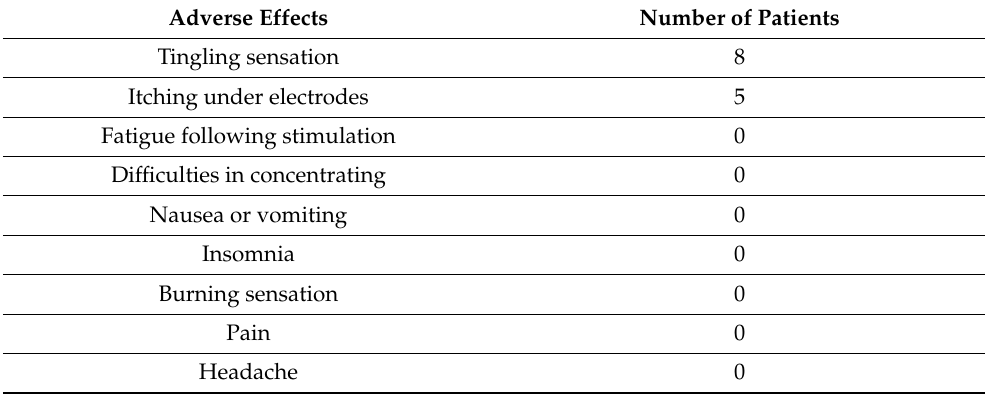
Table 1. Adverse